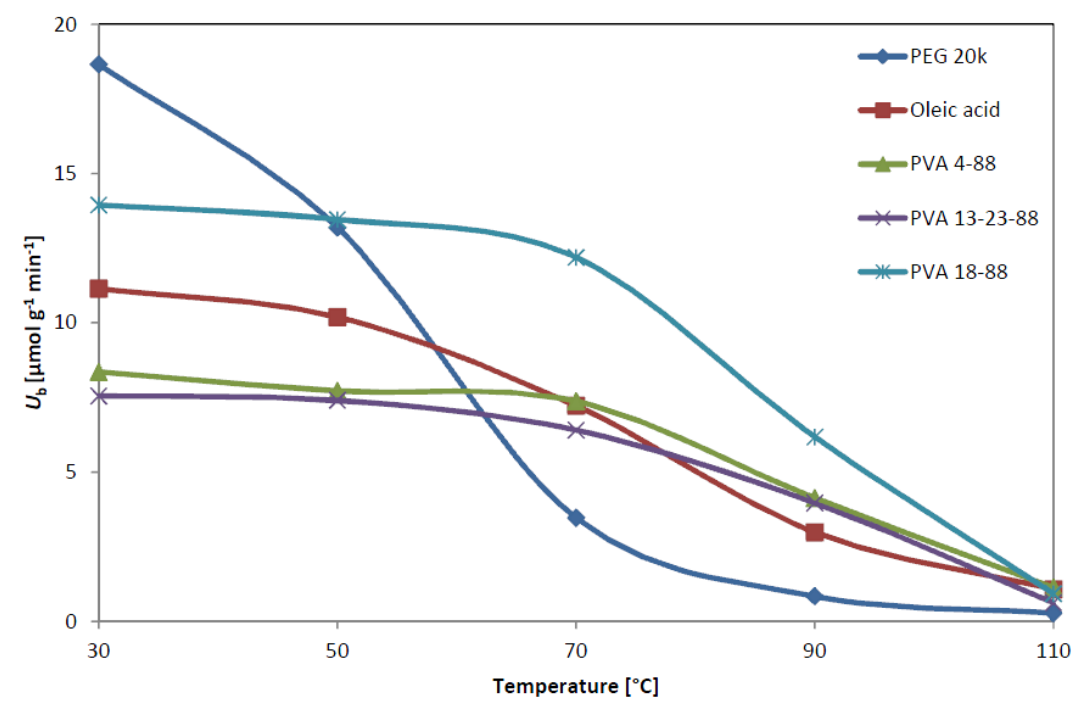
Figure 2. Thermal stability of adsorbed Bc L preparations in kinetic resolution of rac - 1a